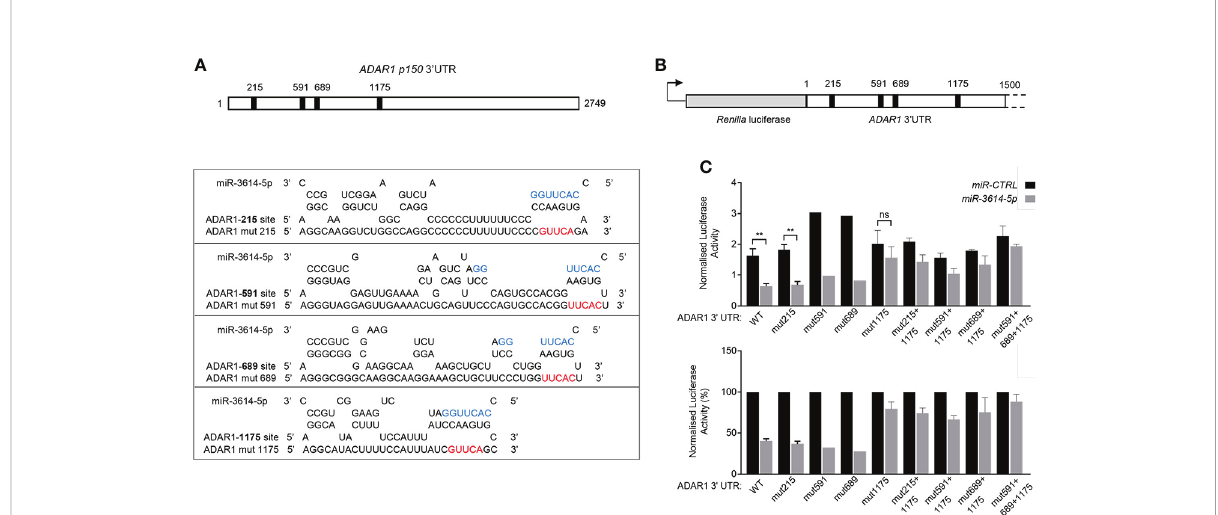
FIGURE 5 MiR-3614-5p targets ADAR1 3 ’ UTR through one major binding site. (A) Schematic diagram of the 3 ’ UTR of the p150 ADAR1 transcript. Black boxes indicate the location of the four predicted binding sites of miR-3614-5p . Site 215 matches to miR-3614-5p positions 2-8 of the seed sequence with an A opposite to position 1. Site 1175 matches to miR-3614-5p positions 2-10. Site 591 and site 689 are two non-canonical 5-mer binding sites. The RNAhybrid miRNA target prediction tool was used (https://bibiserv.cebitec.uni-bielefeld.de/rnahybrid). Mutant ADAR1 target sites (mut215, mut591, mut689, mut1175) were generated by mutating 5nt complementary to the 5 ’ seed region of miR-3614-5p . The seed sequence is in blue. The mutated nucleotides are in red. (B) Schematic diagram of the 1.5 kb ADAR1 3 ’ UTR sequence containing the four predicted miR-3614-5p binding sites (black squares) cloned downstream of Renilla luciferase in the psiCHECK-2 vector. (C) Luciferase assay to assess direct interaction of miR-3614-5p with the ADAR1 3 ’ UTR. HeLa cells were retrotransfected with the miR-3614-5p mimic or the non-targeting control mimic (50nM) and the next day transfected with the dual luciferase reporter psiCHECK-2 carrying the ADAR1 3 ’ UTR, as in (B) . Twenty four hr later Renilla luciferase activity was measured and normalized to the internal fi re fl y luciferase control (top panel). WT and mut1175 data: mean of four experiments each in triplicate. Mut215 data: mean of 3 experiments each in triplicate. Mut591, mut689 data: one experiment in triplicate. Data on combined mutations: mean of two experiments each in triplicate. Statistics is available only for results with 3 independent experiments. Data represented as mean ± SEM. *p<0.05, **p<0.01, ns = not signi fi cant. Normalised luciferase activities (top panel) are represented as percentage of the control mimic (bottom panel). Data are represented as mean ± SEM.